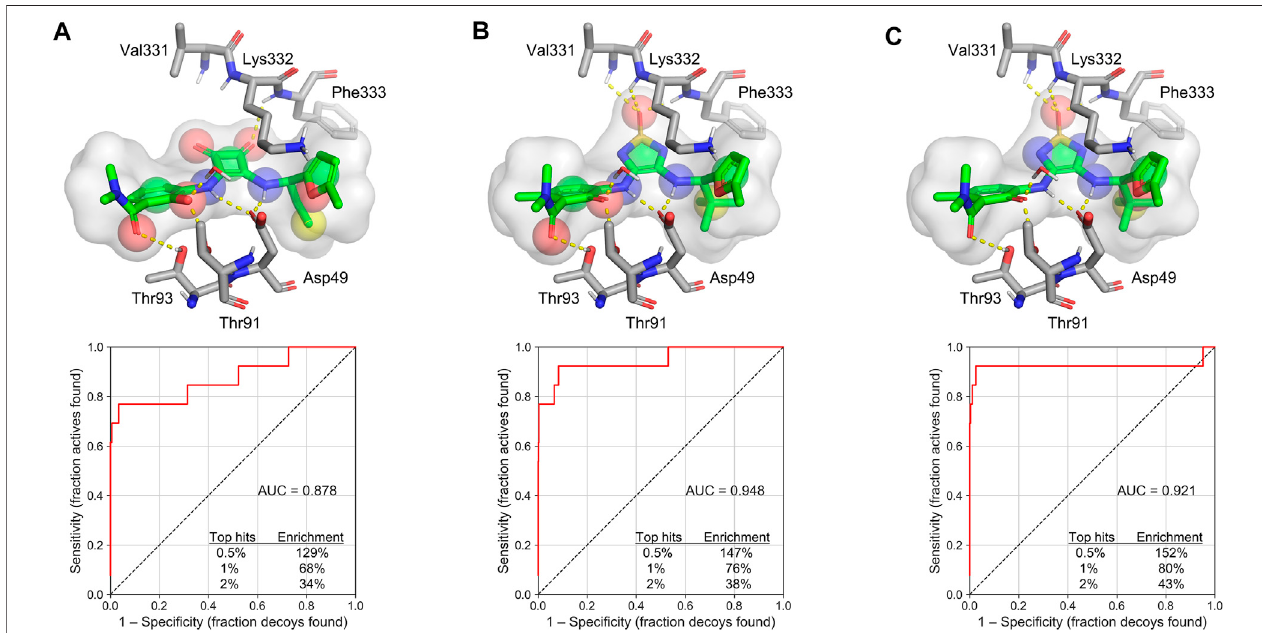
FIGURE 5 | ROCS models and their corresponding ROC plots (A) Navarixin (B) cmp2105 with relevant color features as determined from the crystal structure, and (C) cmp2105 with color features extending into the inner part of the binding pocket. The color features are shown as spheres: hydrogen bond acceptor (red spheres), hydrogen bond donor (blue spheres), hydrophobic region (yellow spheres), and ring (green spheres). AUC = area under the